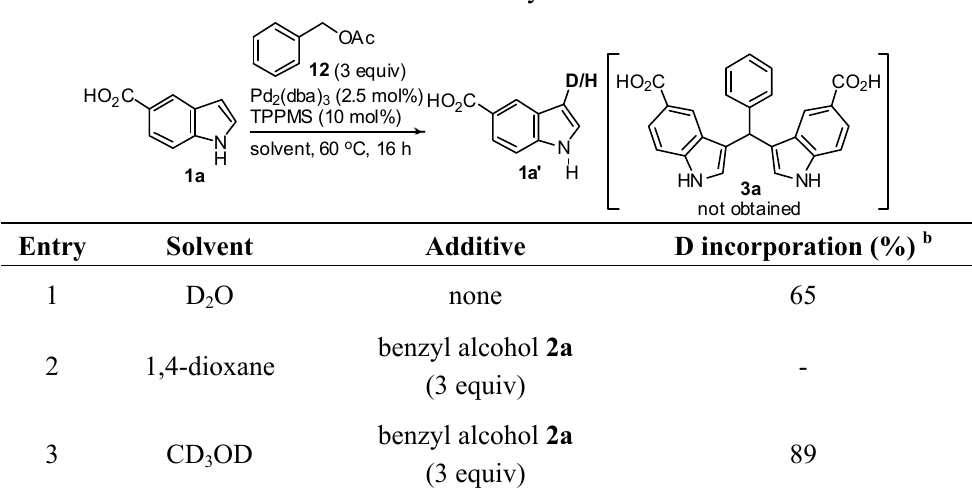
Table 3. Use of benzyl acetate 12 a .